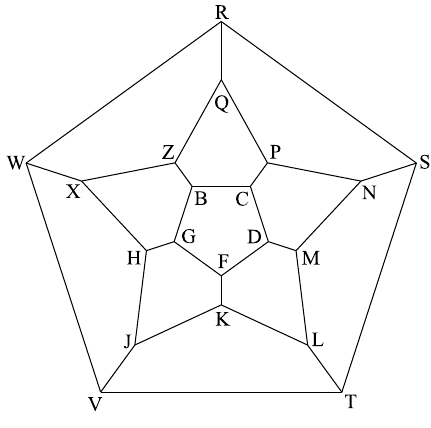
Fig. 2. Hamilton’s dodecahedral